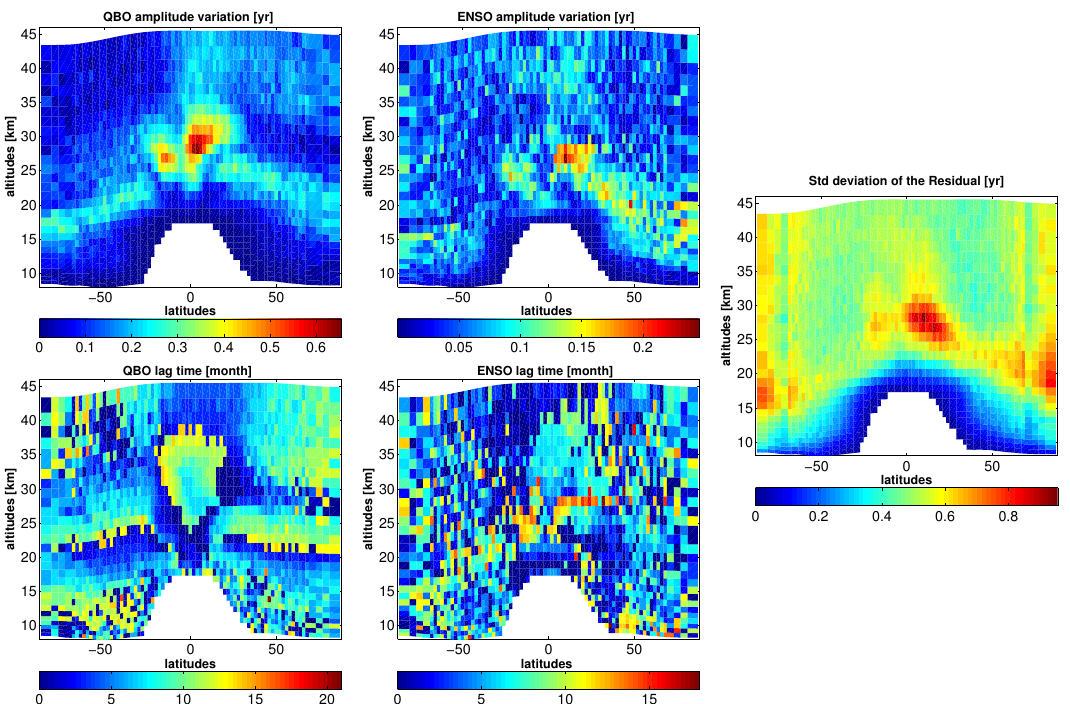
Fig. 12. (Left): altitude-latitude cross-sections of the amplitude of the age variations attributed to the QBO (upper) and its lag with respect to the CDAS QBO index (lower). (Mid): same for the amplitude and lag of the age variability correlated with ENSO MEI index. (Rigth): standard deviation of the residual in Eq. (4).